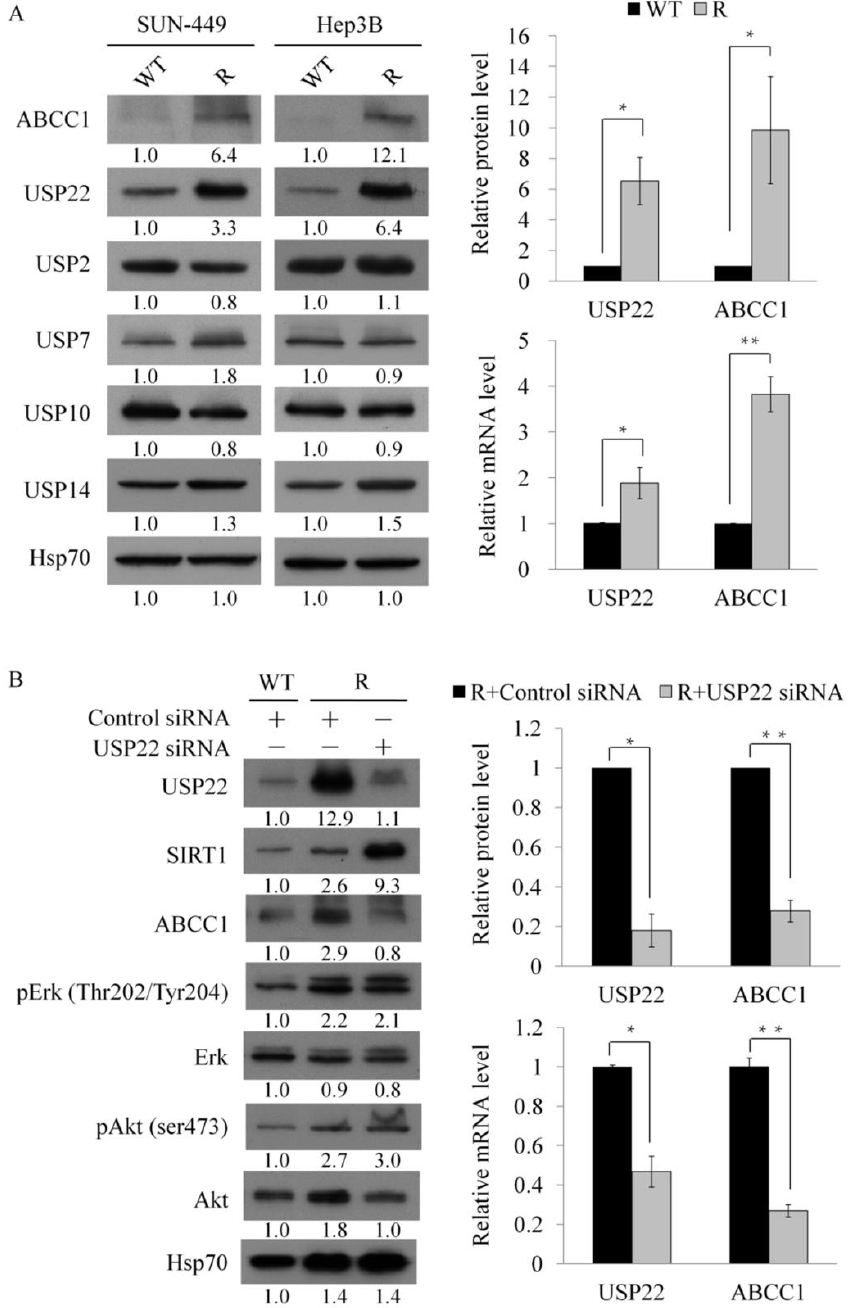
Figure 3. Regulation of multidrug-resistant proteins by USP22 in sorafenib-resistant HCC cells: ( A ) Expression of USPs analyzed by western blotting and RT-qPCR in WT and sorafenib-resistant (R) cells. *: p < 0.05; **: p < 0.01 compared with WT group. ( B ) Expression of multidrug-resistant proteins in USP22 knockdown and sorafenib-resistant Hep3B cells analyzed by western blotting and RT-qPCR. Numeric values listed below the bands represent the indicated protein expression by densitometry analysis relative to levels in the WT cells. *: p < 0.05; **: p < 0.01 compared with control group.